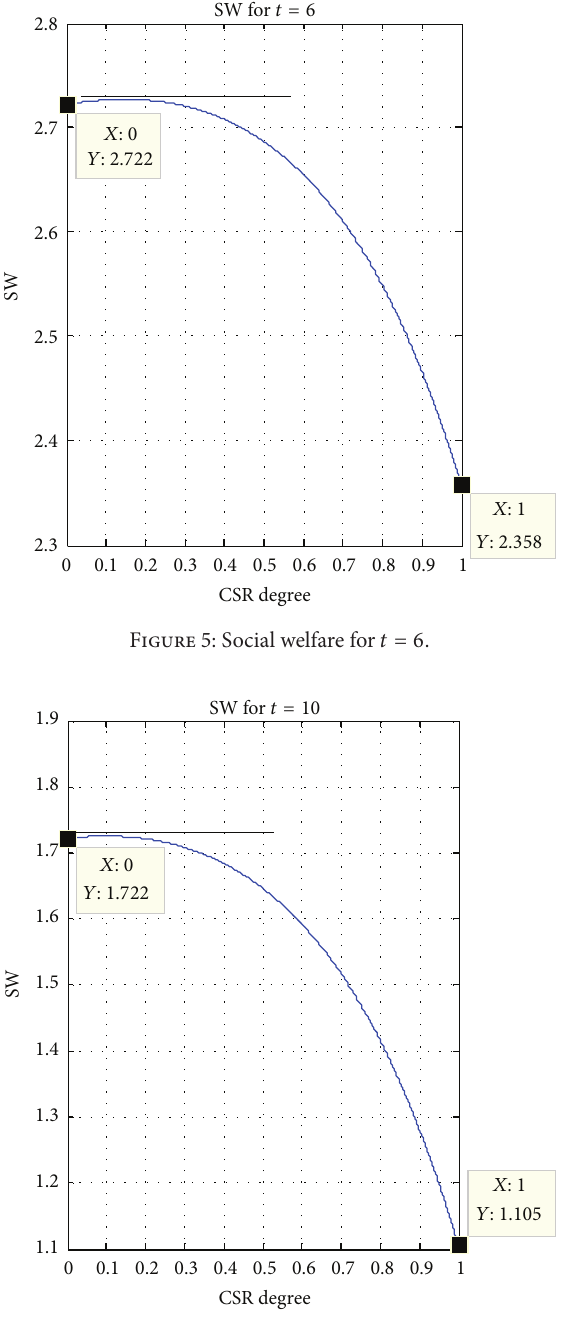
Figure 6: Social welfare for 𝑡 = 10 .